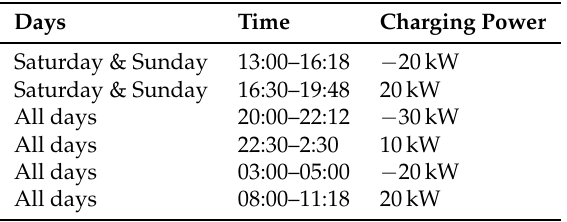
Table 10. Adjusted schedule for the battery storage system.